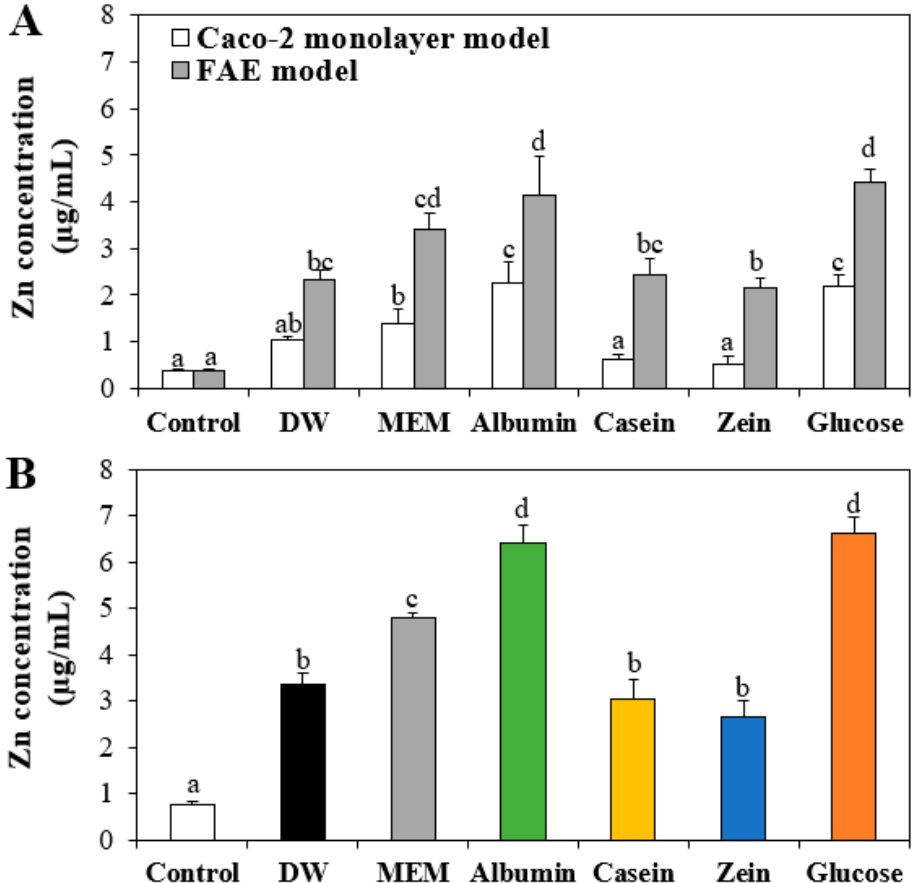
Figure 7. Effect of interactions between ZnO NPs and food proteins or glucose on ( A ) intestinal transport of ZnO NPs using in vitro models of Caco-2 monolayers and human follicle-associated epithelium (FAE) and ( B ) total combined intestinal transport amounts through both Caco-2 monolayer and FAE models after 6 h. Cells without ZnO NPs were used as controls. Different lowercase letters (a–d) indicate significant differences among control and ZnO NPs interacted with DW, MEM, food proteins, or glucose ( p < 0.05).